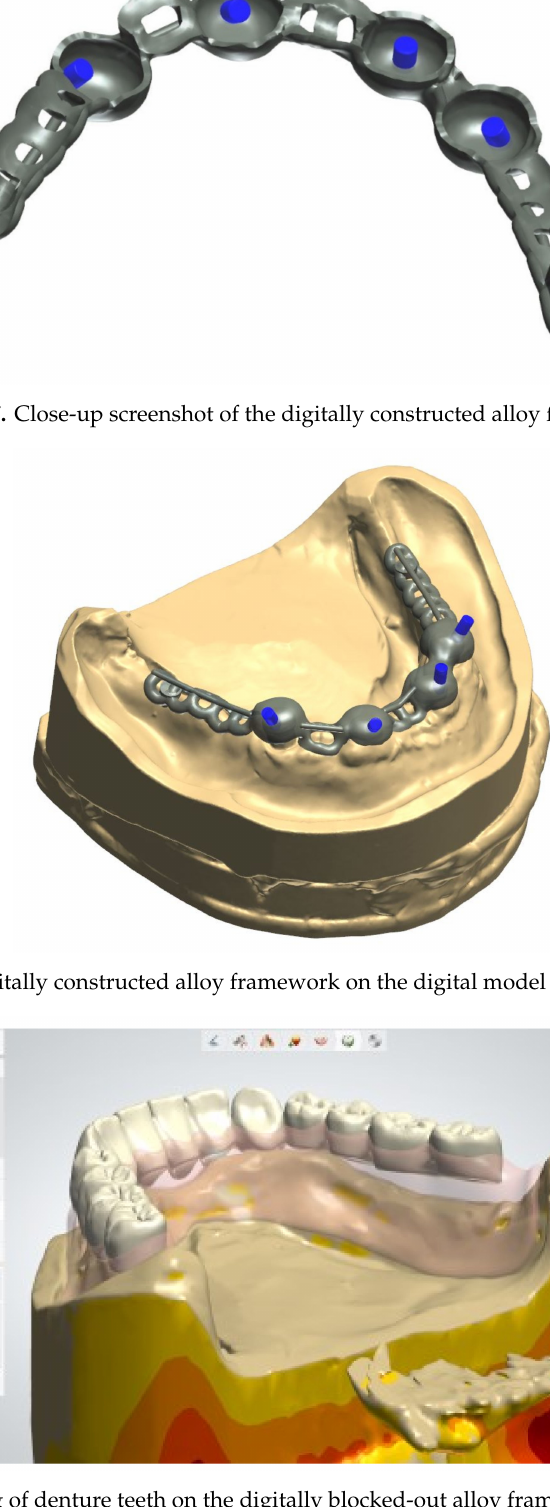
Figure 9. Positioning of denture teeth on the digitally blocked-out alloy framework in the lower